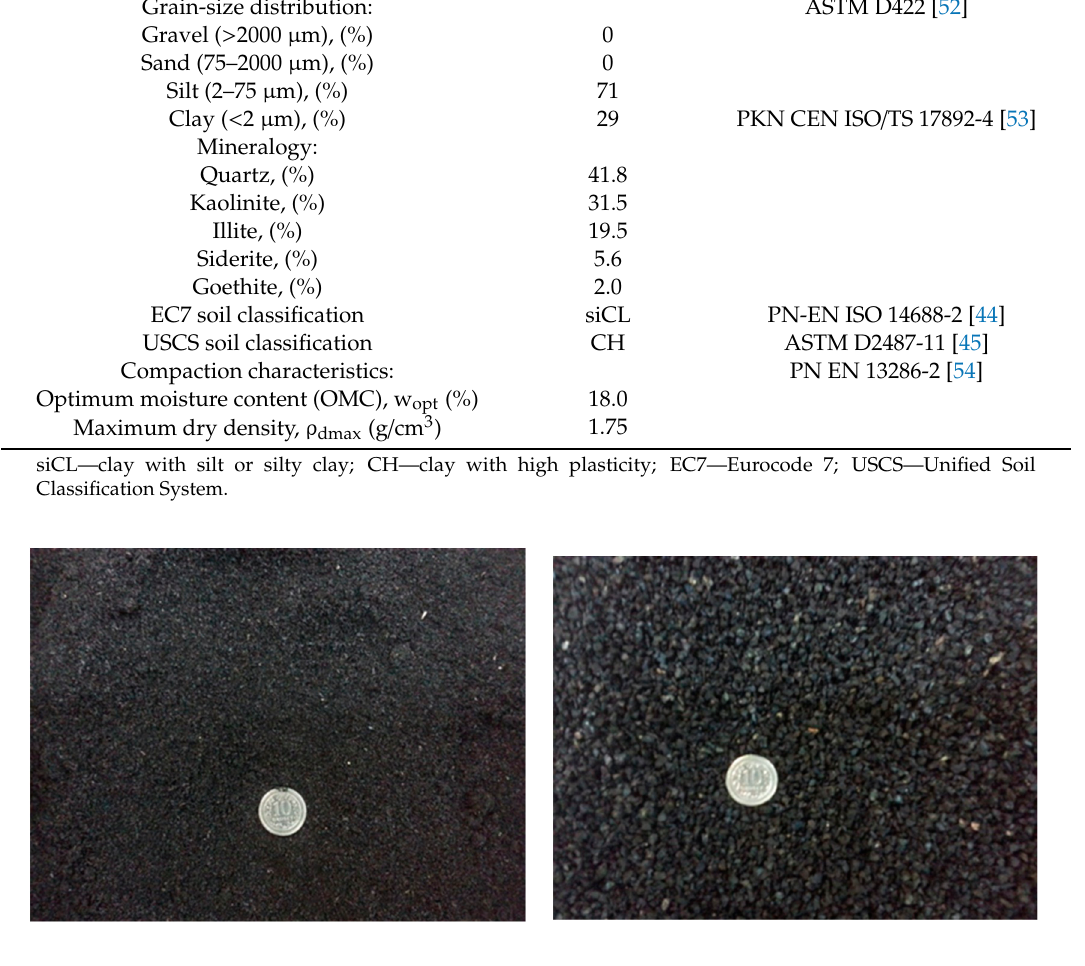
Table 1. Basic geotechnical properties of red clay (siCl/CH) [16,43].